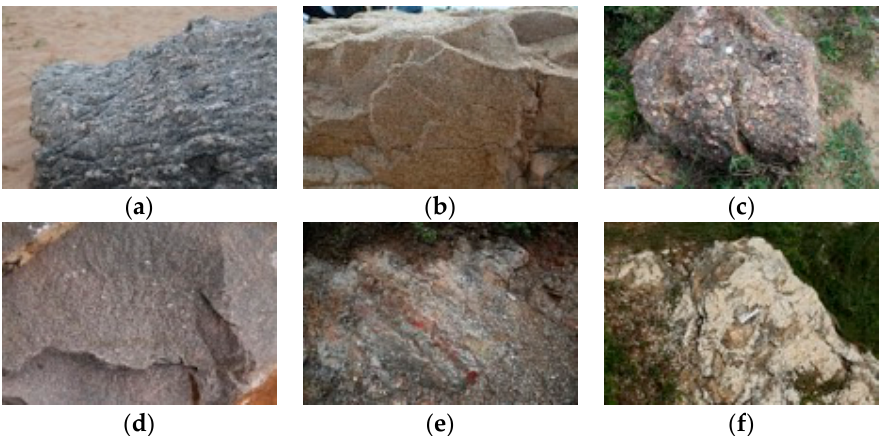
Figure 5. The six types of rock in the field: ( a ) mylonite, ( b ) granite, ( c ) conglomerate, ( d ) sandstone, ( e ) shale, and ( f ) limestone.